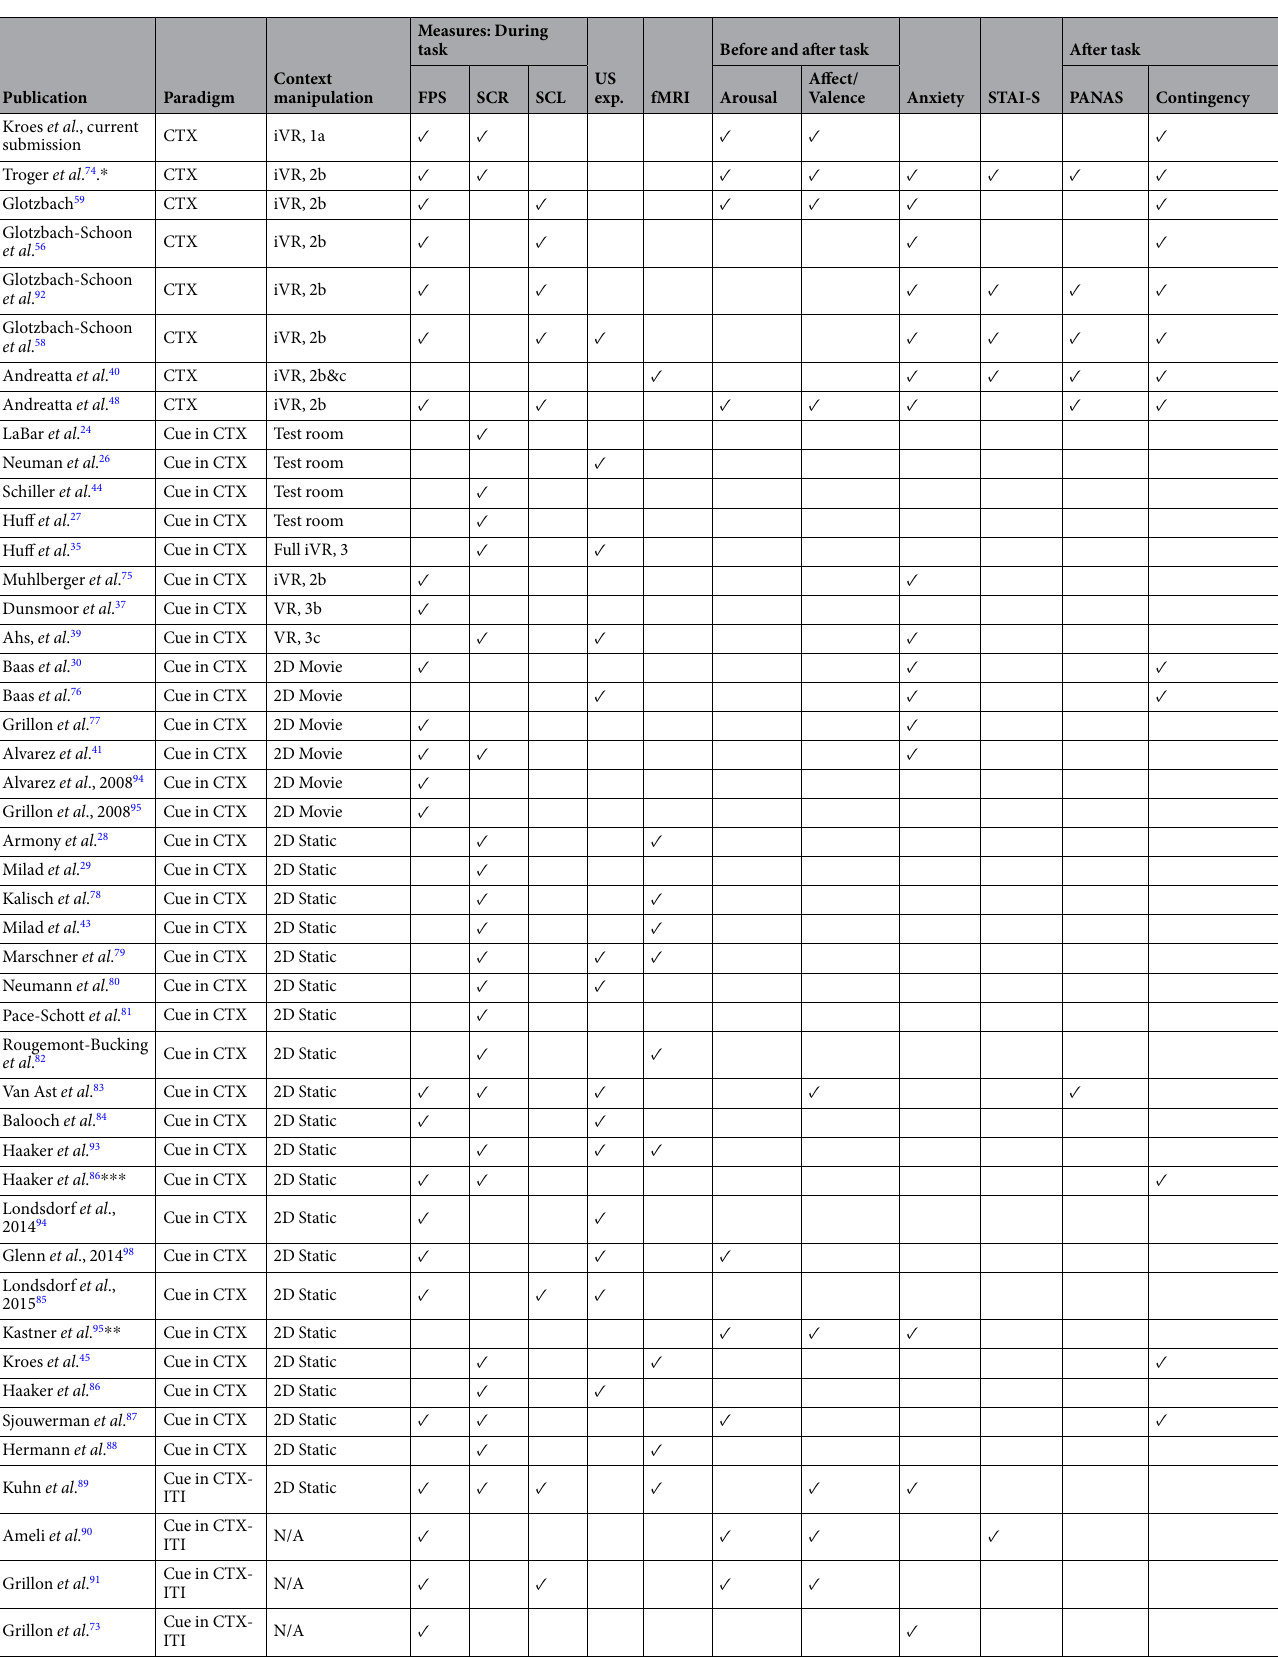
Table 1. Literature overview context conditioning in humans. Paradigm: CTX = context